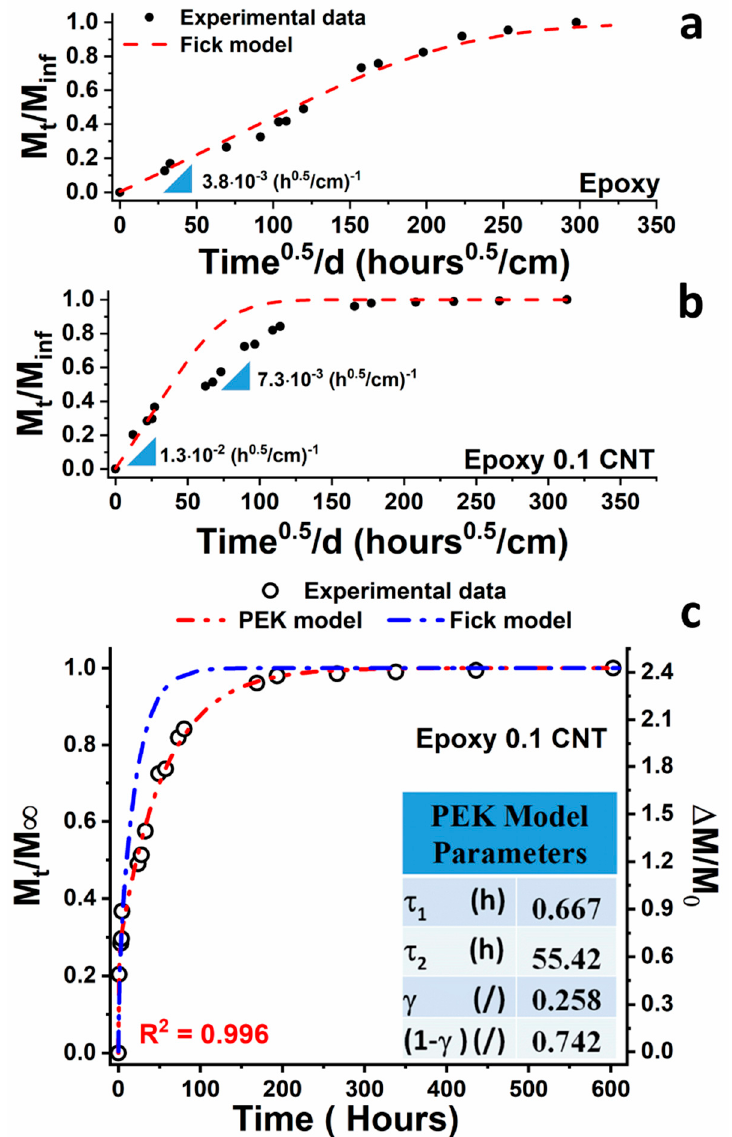
Figure 4. M t /M ∞ against the square root of time of ( a ) the pristine resin and ( b ) resin with 0.1% CNT. ( c ) Water absorption curves as a function of the immersion time ((M t /M ∞ ) left vertical axis; ∆ M/M 0 right vertical axis); symbols are experimental data; curves are calculated by the Fick diffusion (blue) and PEK models (red).